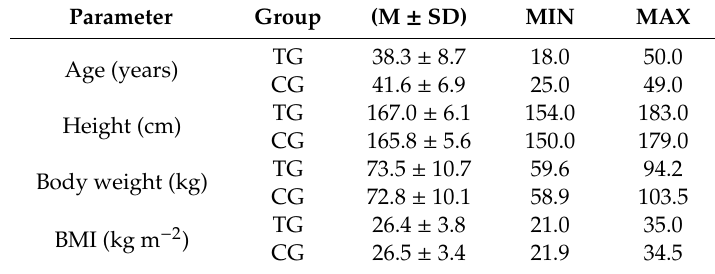
Table 1. Descriptive and anthropometric characteristics of the subjects in TG ( n = 40) and CG ( n = 37). Parameter Group